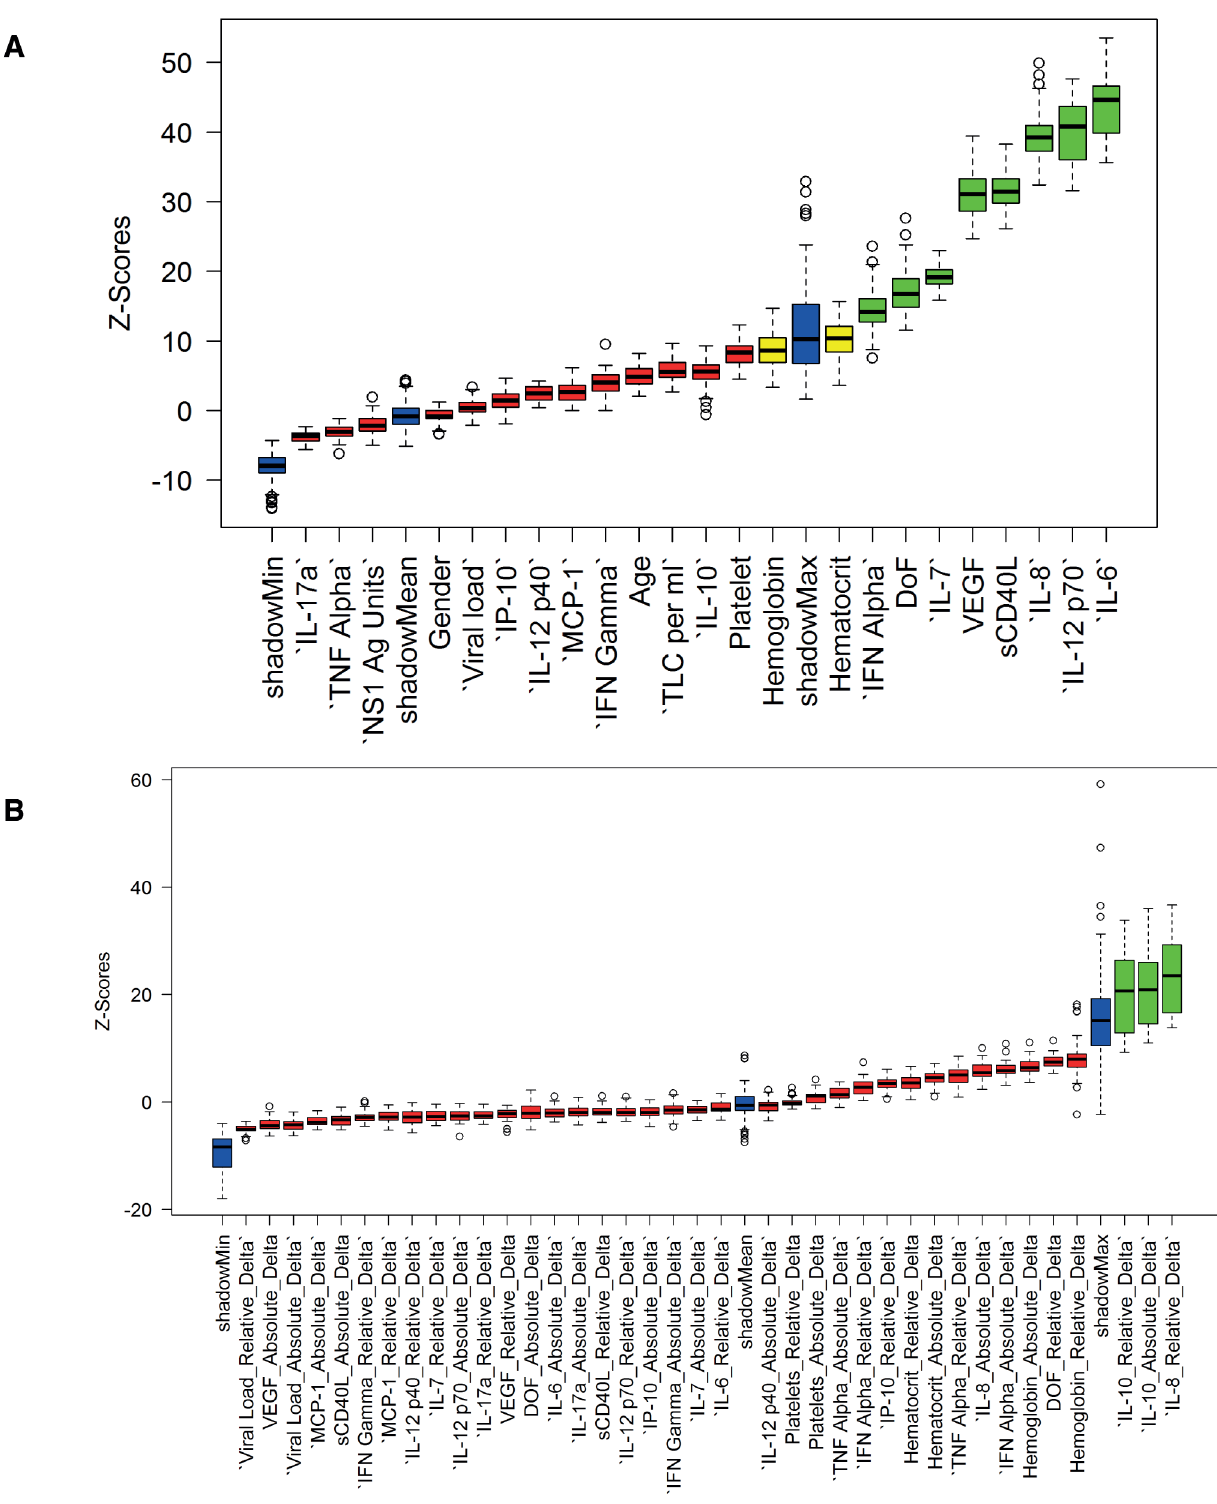
Fig 7. Multivariate selection of features of dengue severity and recovery. (A) The boxplots represent the distribution of variable importances after adjusting for the interactions among the variables. The minimal set of selected features (green) are the ones whose medians lie above the maximal possible median importance in the shadow data (see text for description). Eight parameters out of all available clinical and biochemical parameters were selected as important for prediction of the severity classes (SD, DW and DI). (B) Identifying markers of recovery from SD using the Boruta algorithm. All parameters